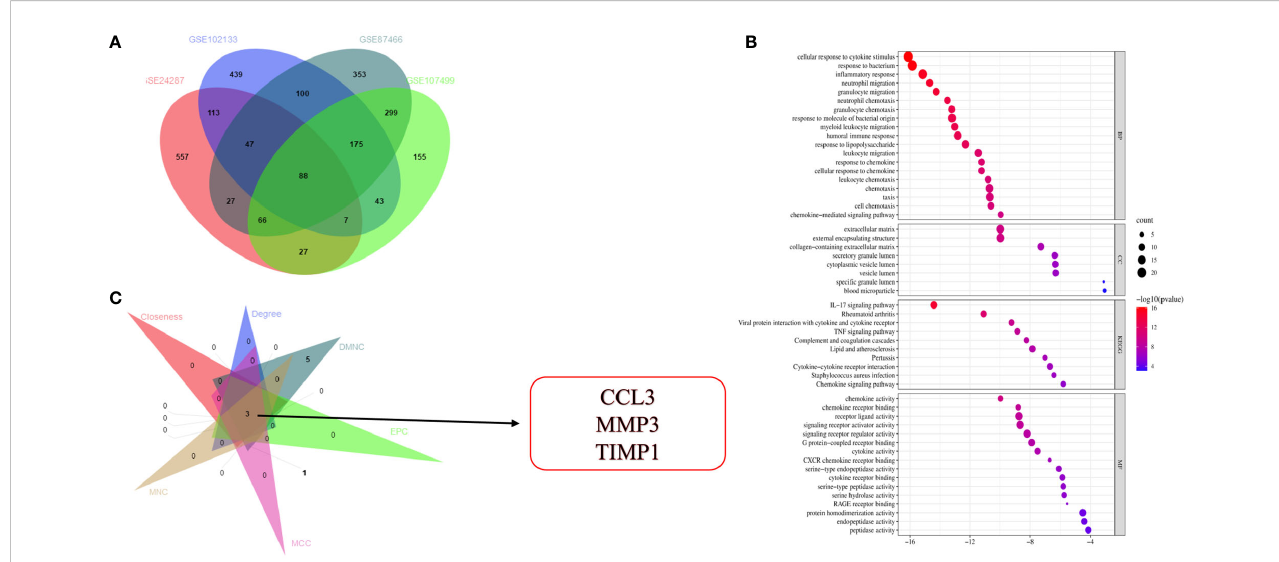
FIGURE 1 Identi fi cation and functional annotation of DEGs and hub gene selection. (A) Venn diagram shows overlapping genes from four gene sets. (B) GO and KEGG pathway enrichment analysis of DEGs. (C) Identi fi cation of three hub